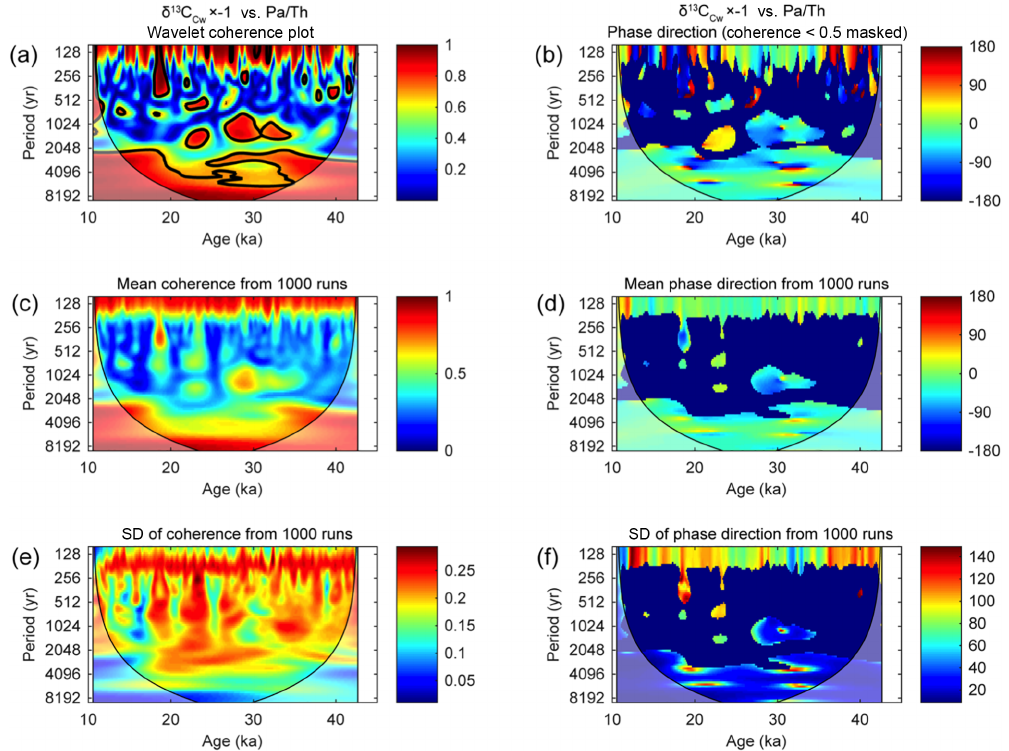
Figure 5. Cross-wavelet transform of δ 13 C Cw composite record versus MD09-3257 Pa / Th. δ 13 C Cw values have been multiplied by − 1 to allow a straightforward reading of the relative phase between a decrease in δ 13 C and an increase in Pa / Th. (a) – (f) as in Fig.